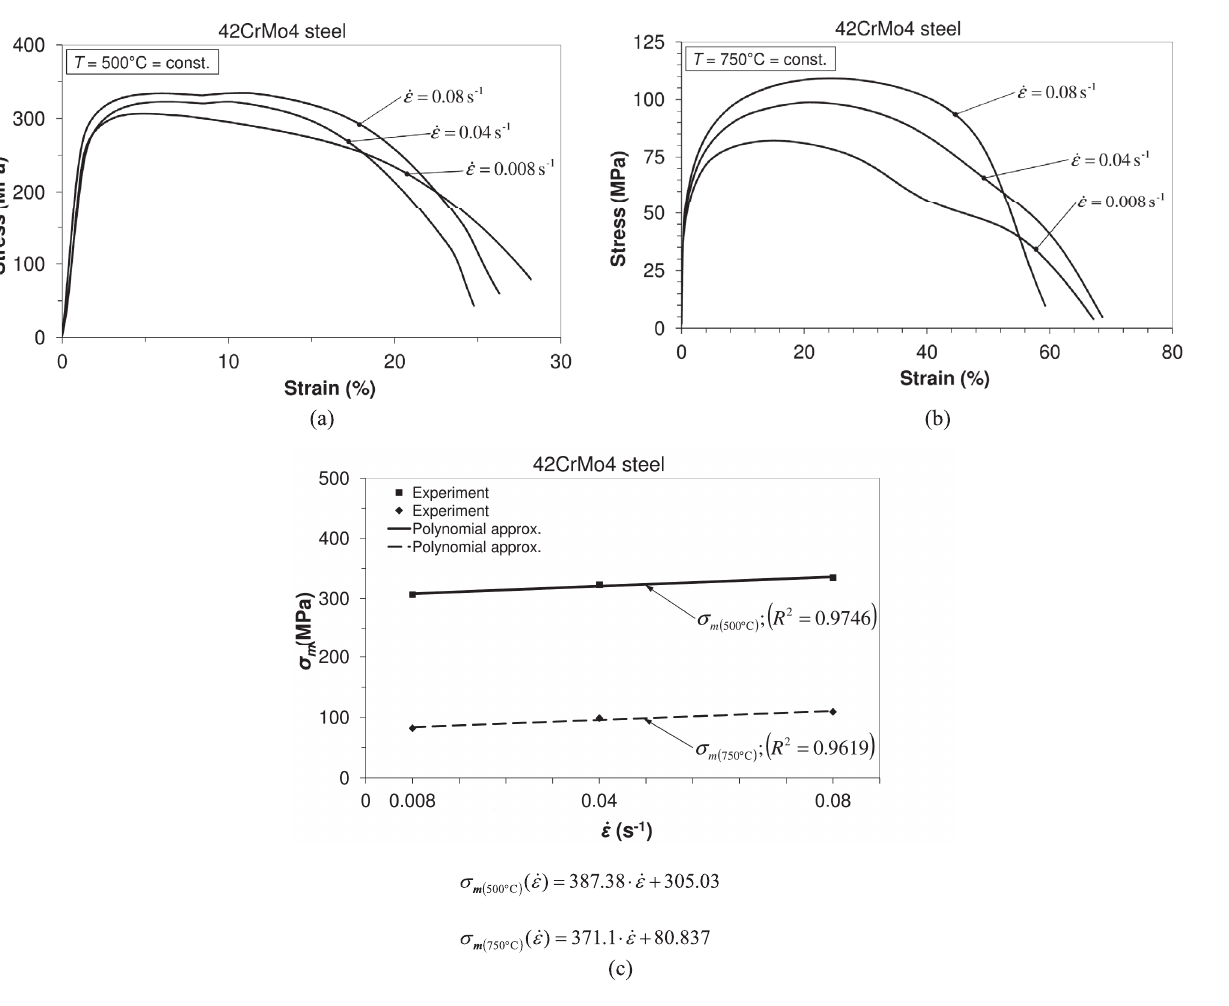
Fig. 3: Tensile strength versus strain rate – 42CrMo4 steel. (a) Stress-strain diagrams for different strain rates at the temperature of 500 °C (773 K). (b) Stress-strain diagrams for different strain rates at the temperature of 750 °C (1023 K). (c) Experimental data and polynomial approximations of tensile strength for strain rates at the temperature of 500 °C (773 K) and 750 °C (1023